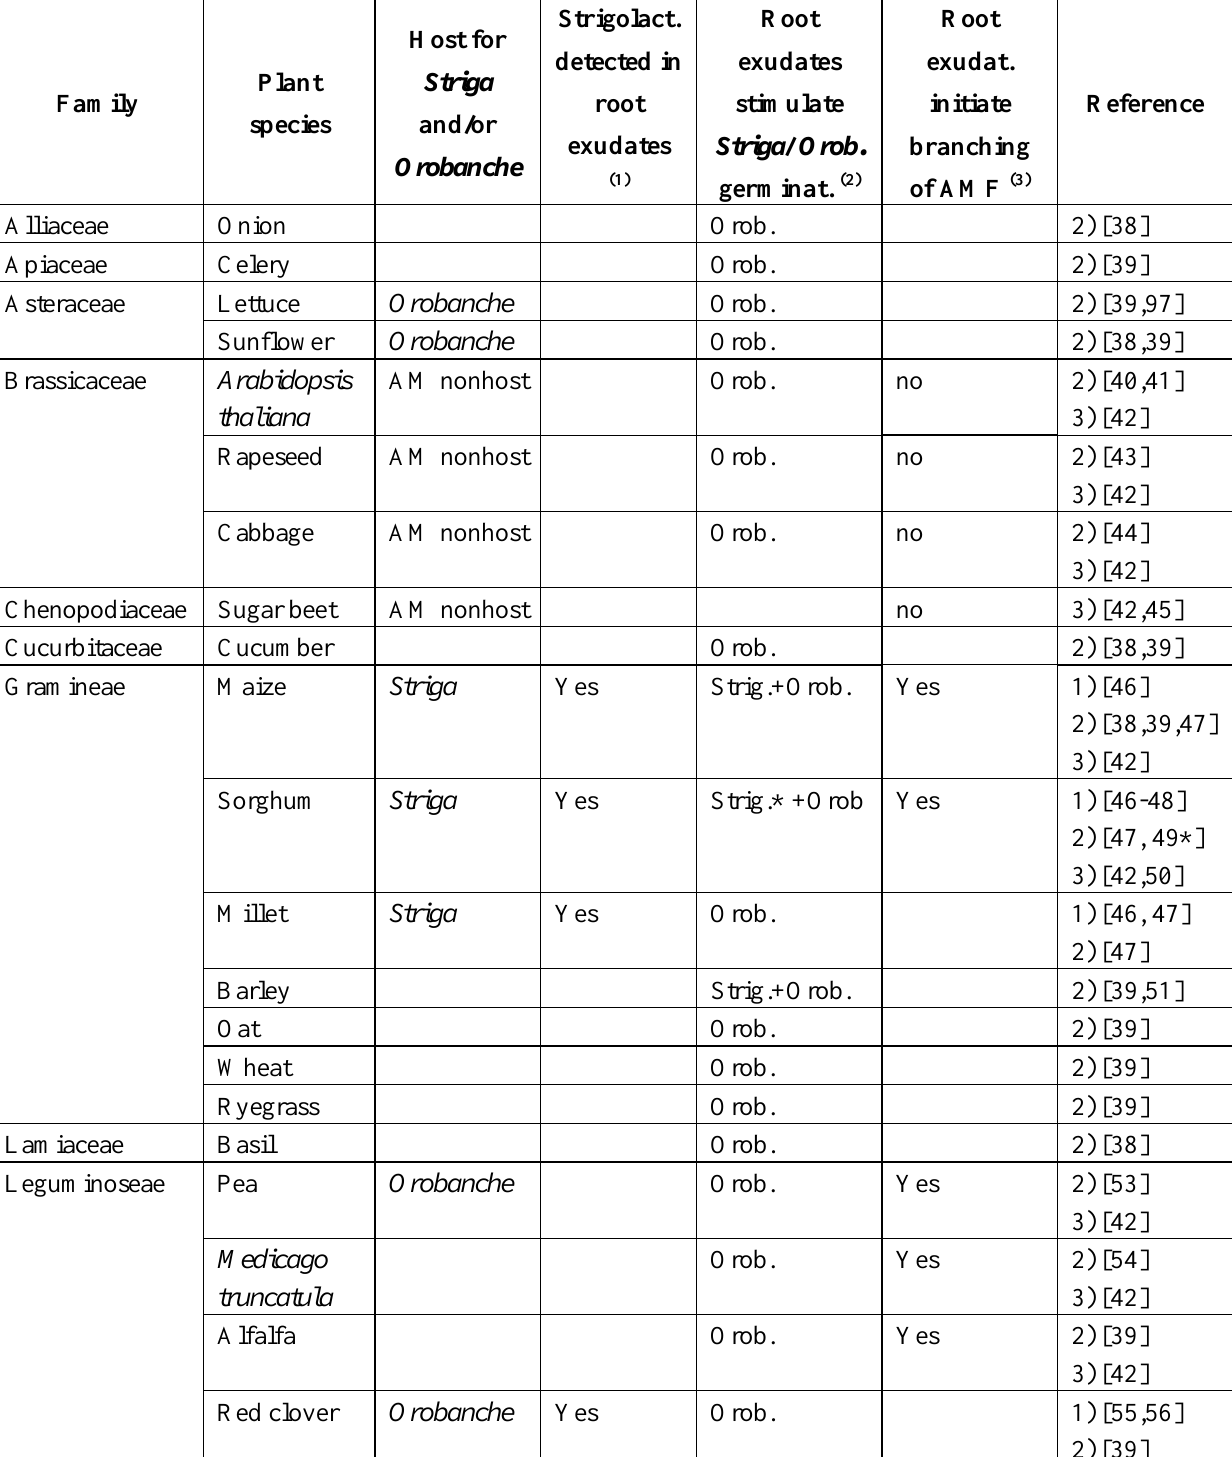
Table 1. Overview on plants were information is available on the presence of strigolactones in root exudates (1) , on the presence of compounds in root exudates exhibiting a stimulatory effect on seed germination of Striga / Orobanche (2) and on the presence of compounds in root exudates stimulating hyphal branching of AMF (3)